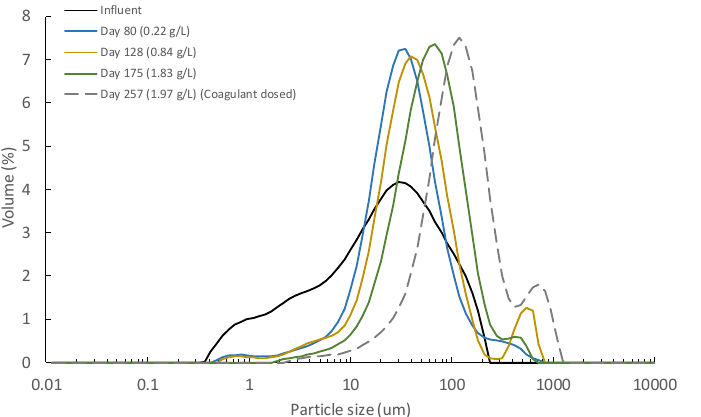
Figure 4. Particle size distribution of the concentrated sludge during the pilot-plant operation. Note that legend shows the day, together with the total suspended solids concentration in the pilot-plant membrane tank during sampling.